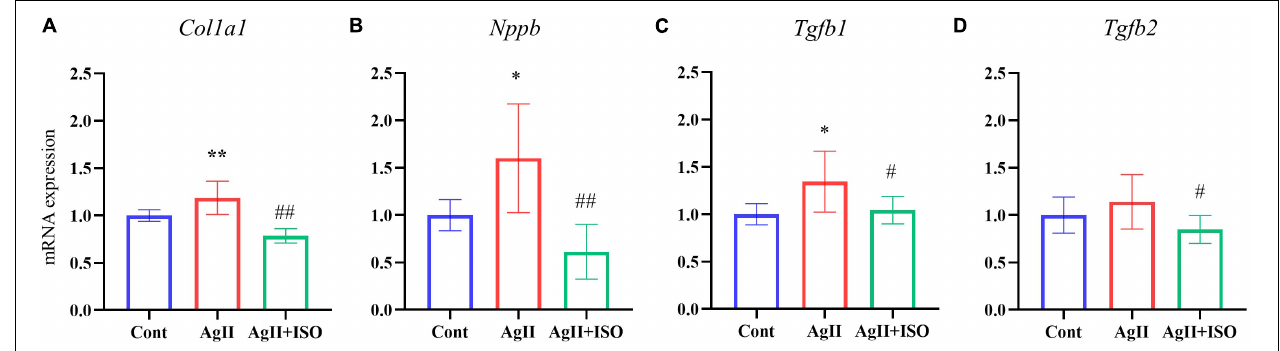
FIGURE 4 | (A–D) The relative expression levels of Col1a1 , Nppb , Tgfb1 , and Tgfb2 evaluated by RT-PCR for the three groups ( n = 6–8 per group). The transcript levels were normalized to 18s and presented as a relative value. * P < 0.05, ** P < 0.01 vs. Cont. # P < 0.05, ## P < 0.01 vs. AgII +